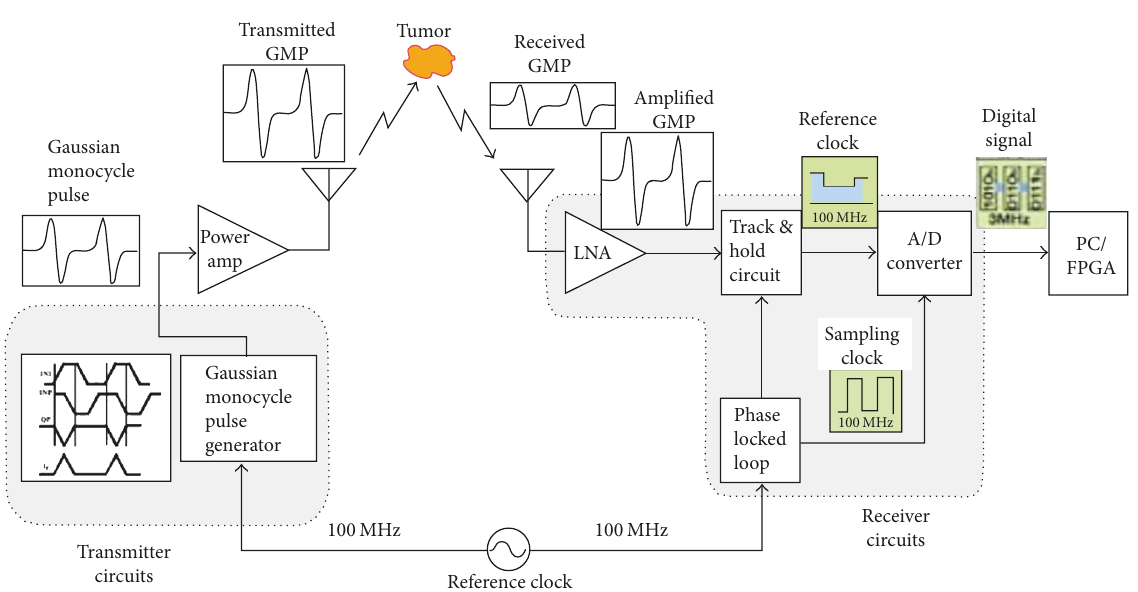
Figure 28: A Hiroshima University concept for a CMOS breast cancer detection system [31]. Image copyright IEEE, used with permission.